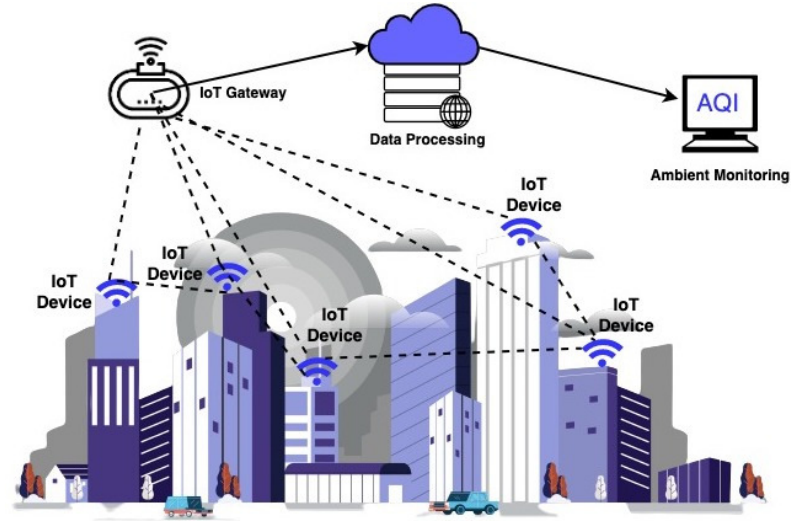
Figure 1. Internet of Things base ambient pollution monitoring and forecasting system